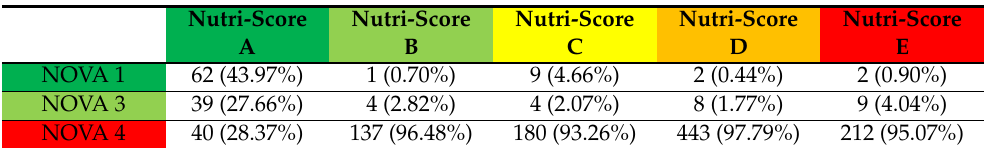
Table 5. Percentage of products in NOVA groups 1, 2 and 4 by Nutri-Score group in the overall sample ( n = 1155).